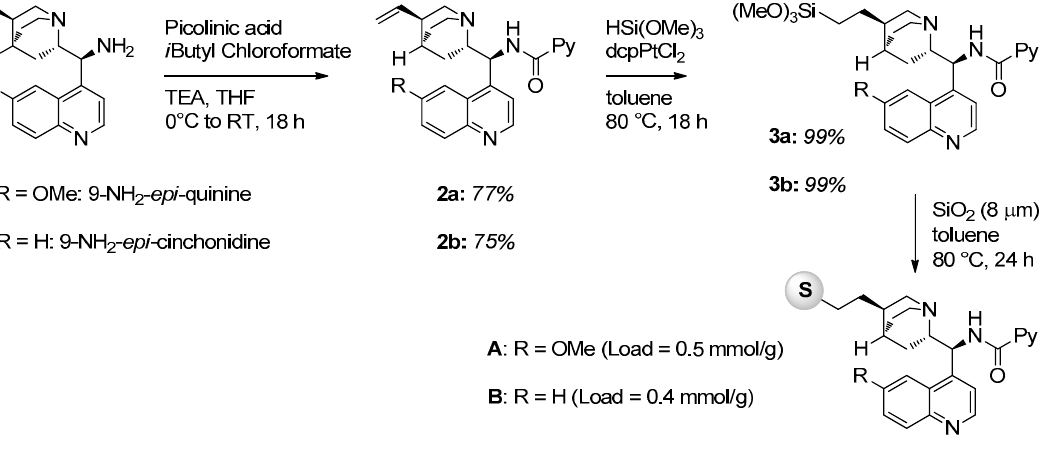
Figure 1. Synthesis of silica-supported catalysts A and B .